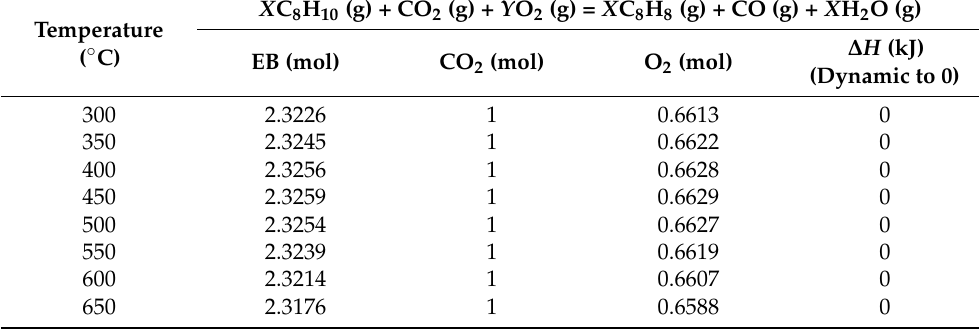
Table 1. Ratio of molar amounts of each reactant required for the enthalpy change ∆ H = 0 for the